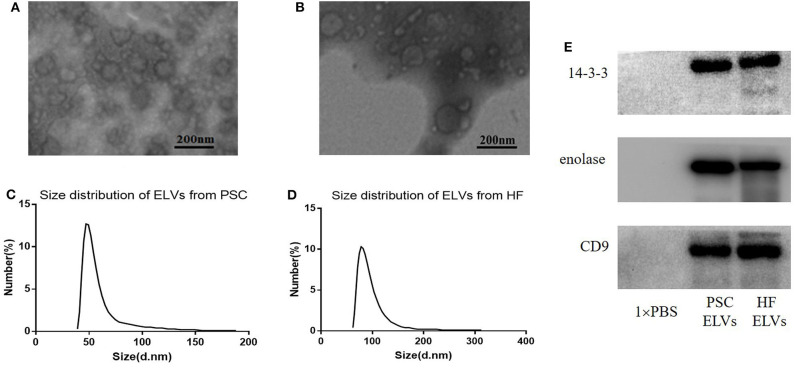
Identification ELVs from protoscoleces (A,C) and hydatid fluid (B,D). (A,B) Images of the rounded or cup-shaped vesicles obtained using negative staining under TEM. Scale bars: 200 nm. (C,D) The diameter distribution analysis of the purified ELVs assessed using nanoparticle tracking analysis. (E) Exosome-associated markers 14-3-3, enolase, and CD9 were measured using Western blotting analysis.